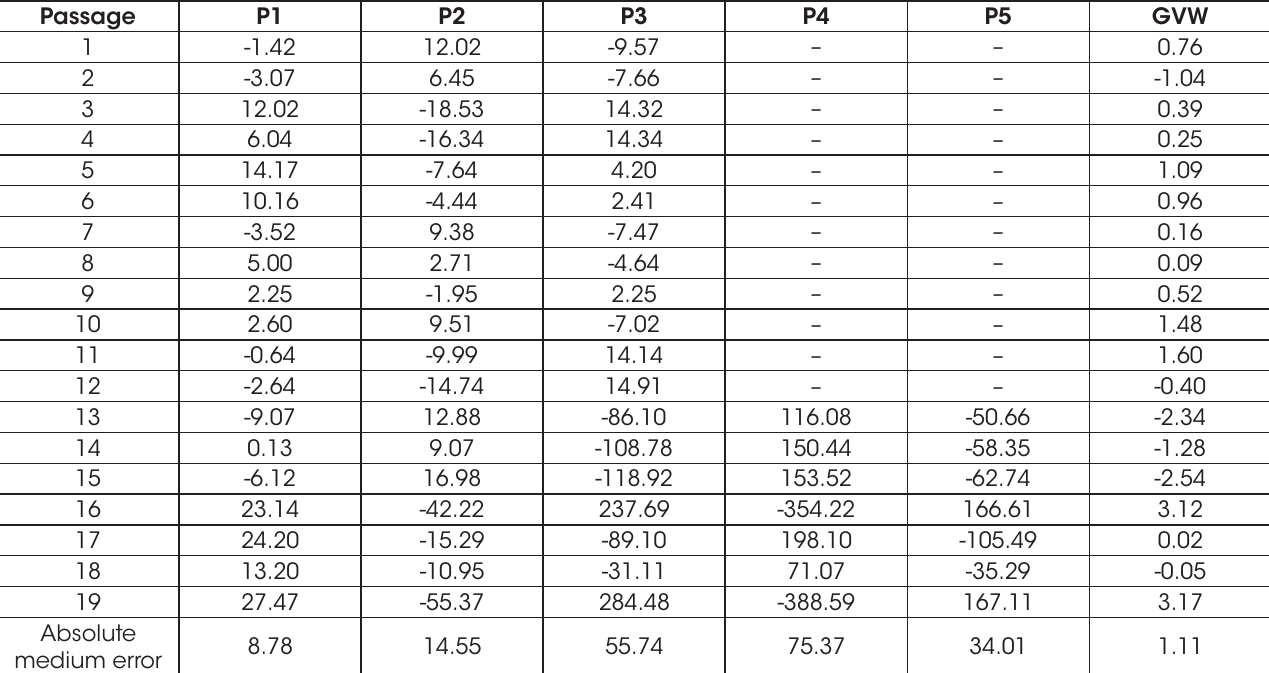
Errors (%) acquired for the passages of the calibration vehicles on lane 2 Passage